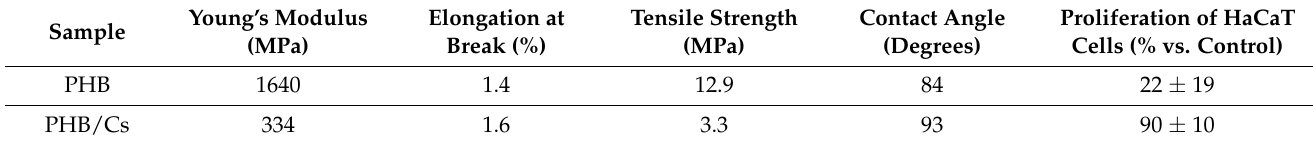
Table 3. Comparison of the properties of PHB and PHB/Cs adapted from